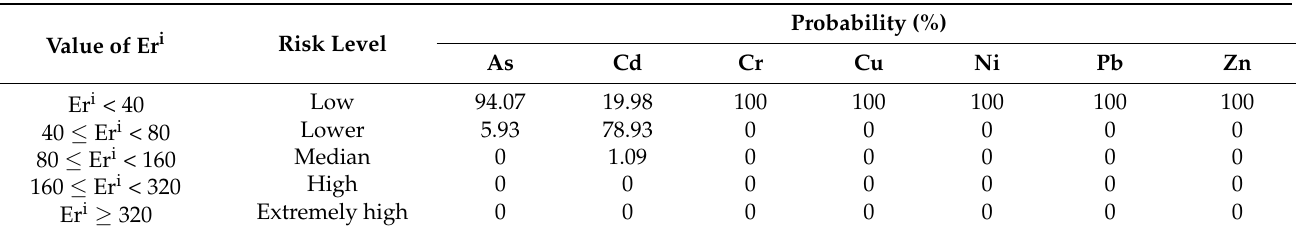
Table 8. Ecological risk analysis results of each PTEs.